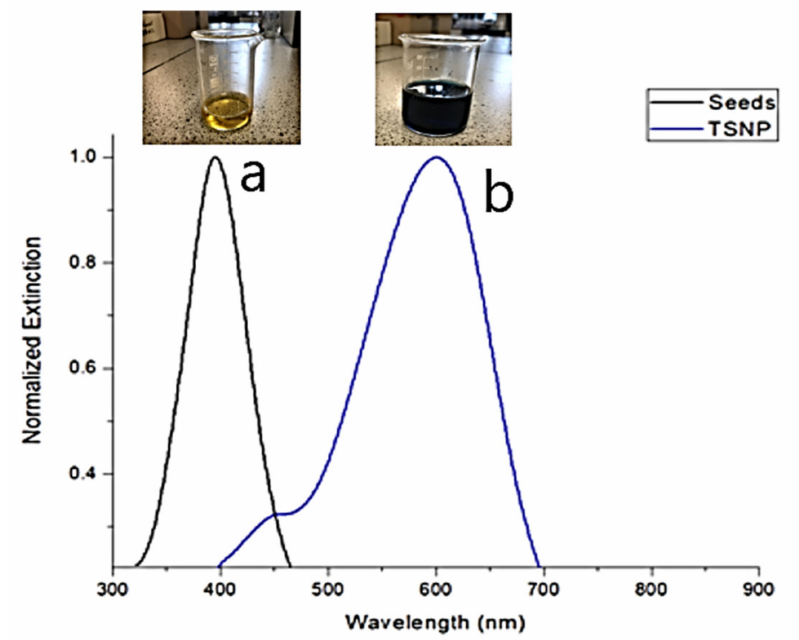
Figure 1. UV-VIS spectrum of ( a ) Ag seeds and ( b )